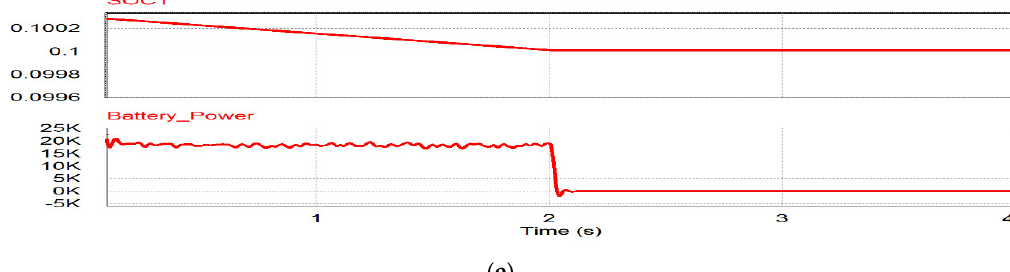
Figure 18. Simulation results of voltage compensation from grid power mode: ( a ) Grid power; ( b ) shunt inverter power; ( c ) series inverter power; ( d ) active and reactive power for sensitive load; ( e ) state of charge of BESS and BESS power.